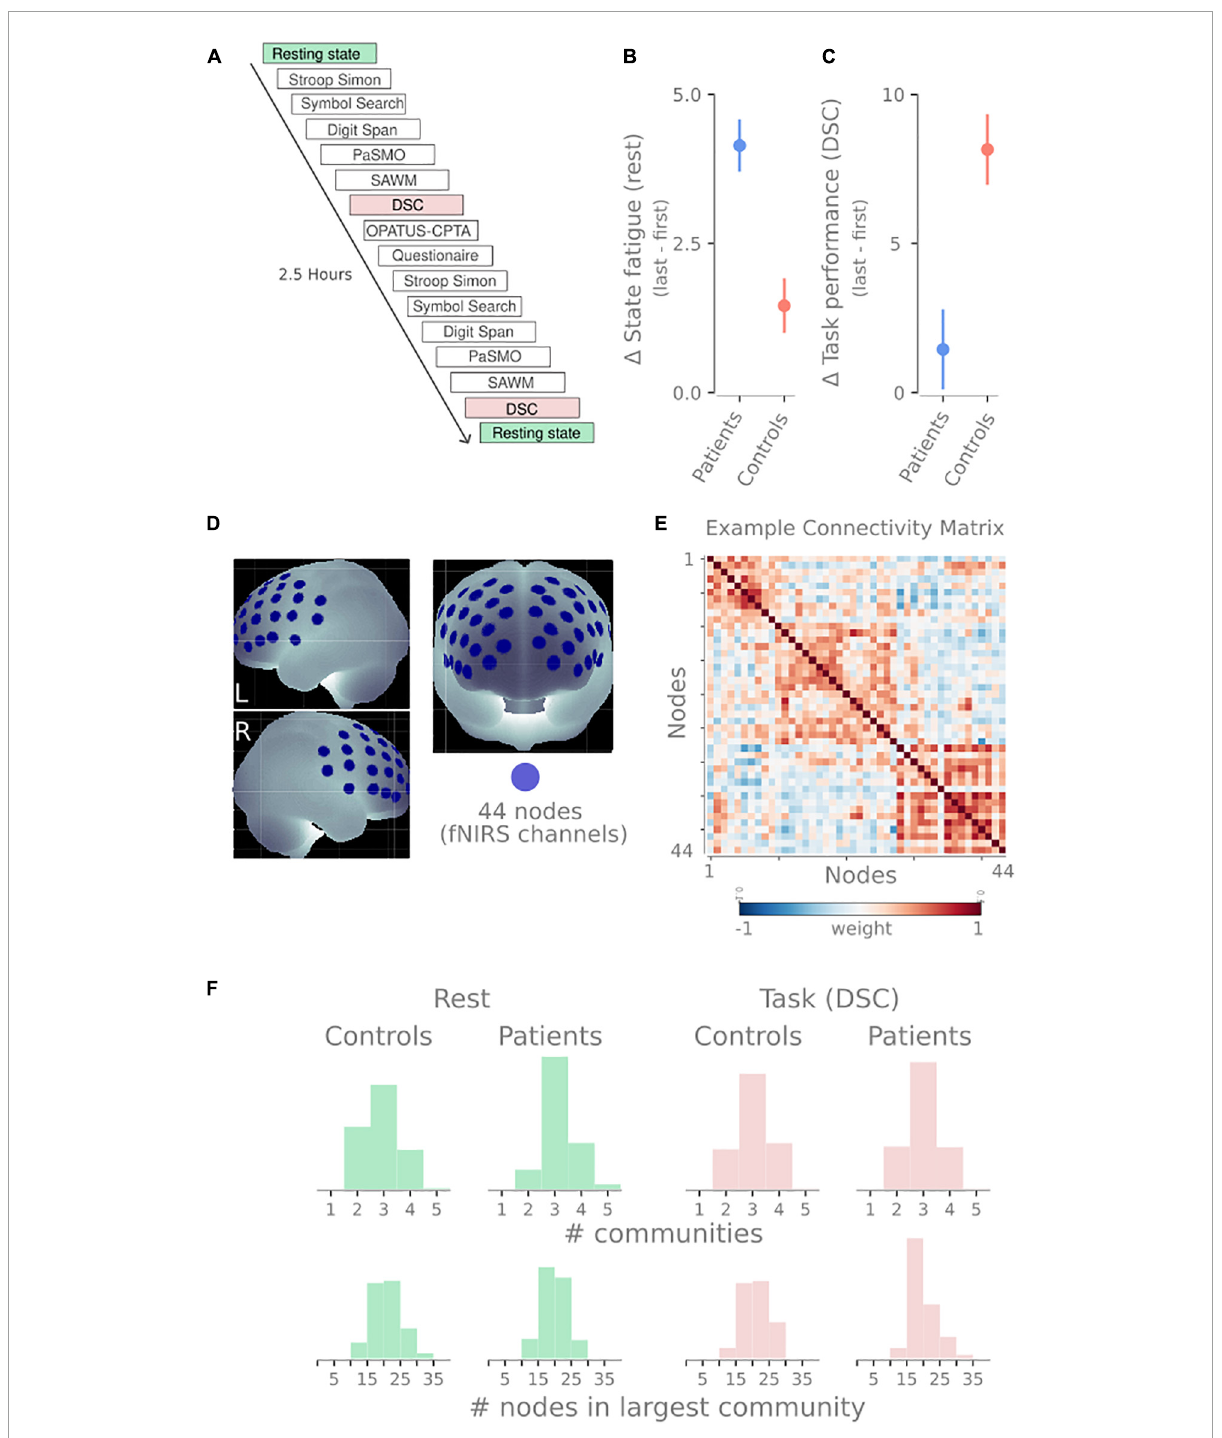
FIGURE2 Overview of design and methodology. (A) Timeline of tasks performed by participants in this study. The blocks analyzed in this manuscript have been highlighted: resting-state sessions (green) and digit symbol coding tasks (DSC, red). (B) The difference in self-reported state fatigue following the resting-state session (last˝Ufirst) for both groups. (C) Difference in task performance in the DSC task (last-first). Panels (C,D) show data previously reported in Skau et al. (2019). (D) The 44 recording sites on the frontal cortex. These 44 recording sites become nodes in the network. (E) An example connectivity matrix from one resting-state session showing three communities for the 44 nodes depicted in panel (B) . Similar to the connectivity matrix in 1A, but with weighted edges instead of binary edges. (F) Descriptive statistics of the community detection properties. Histograms show the number of communities (top) and the number of nodes in the largest community (bottom) for rest (green) and DSC task (red) and both patients and healthy